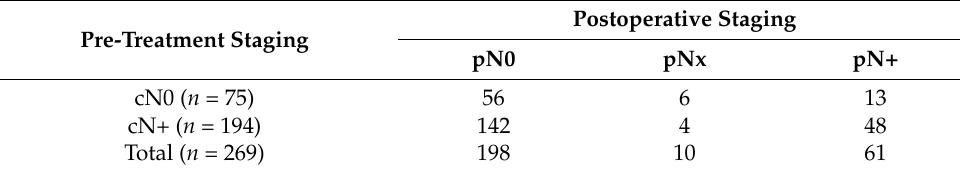
Table 7. Pre-treatment N stage compared with pathologic N stage ( n = 269). Pre-Treatment